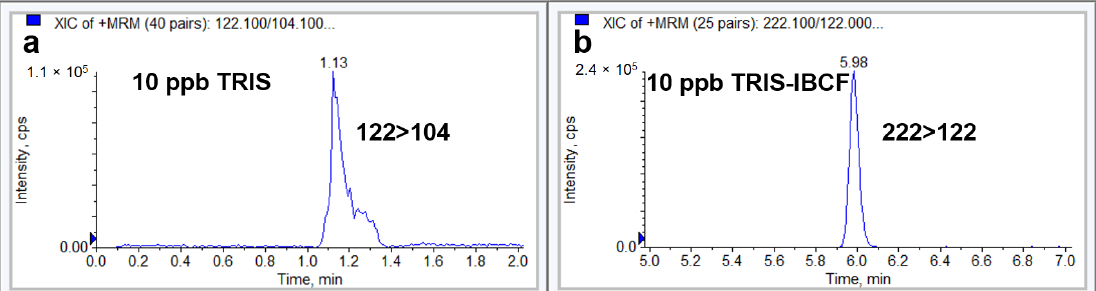
Figure 2. The chromatographic peak shape of TRIS before ( a ) and after derivatization ( b ) with IBCF at 10 ng/mL. at 10